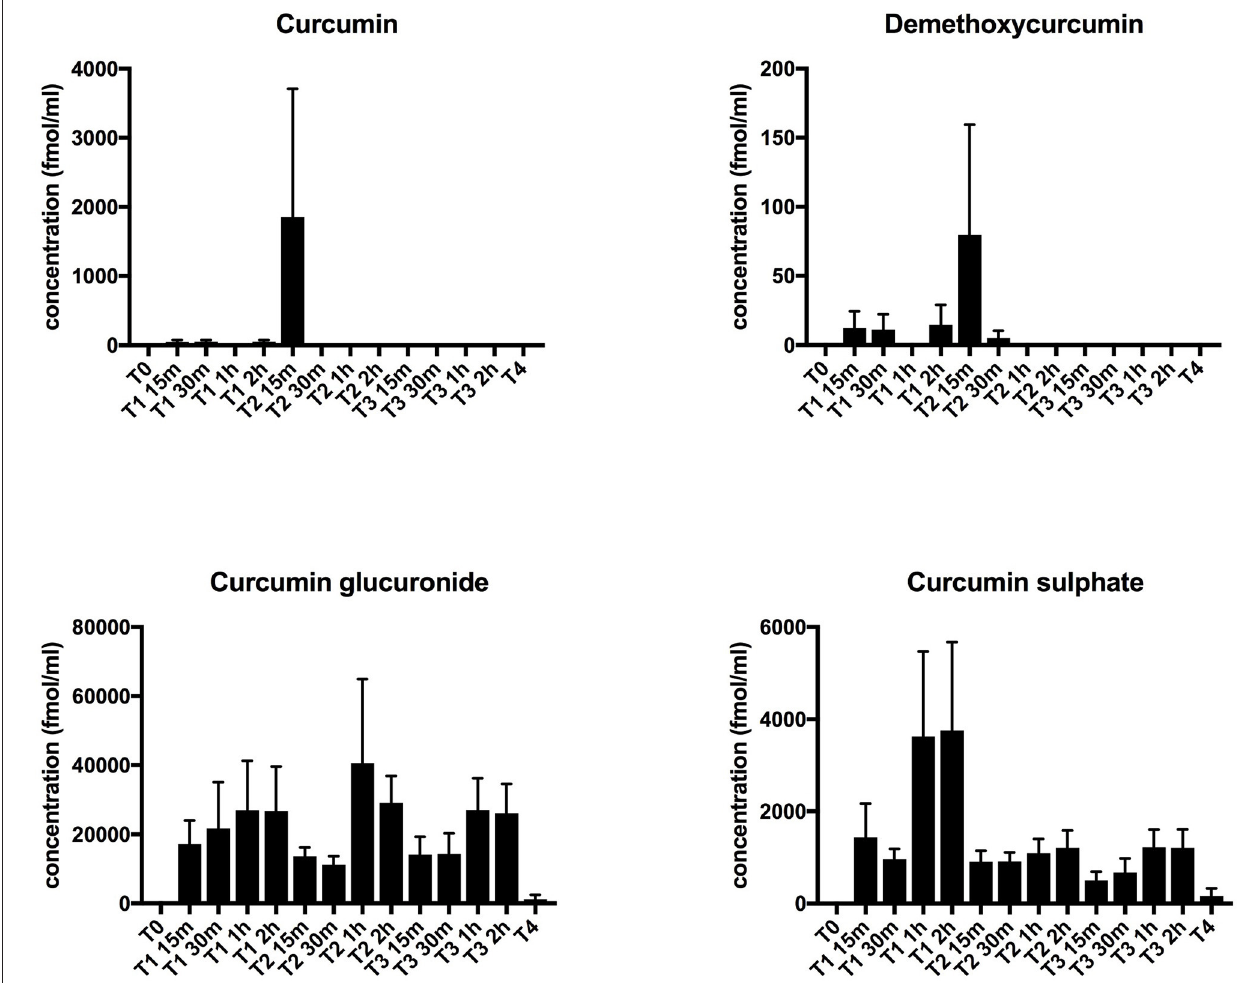
FIGURE 2 | Plasma curcumin levels. Plasma levels of curcuminoids (curcumin and demethoxycurcumin) and their main metabolites (curcumin glucuronide and curcumin sulfate) were determined by LC-ESI-MS/MS. Concentrations are shown in fmol/mL. Results are depicted as mean + standard error of mean. Time points are as follows: T0-baseline, T1-day 1 of treatment, T2-day 7 of treatment, T3-day 14 of treatment, T4, 1 week after last CP dose.